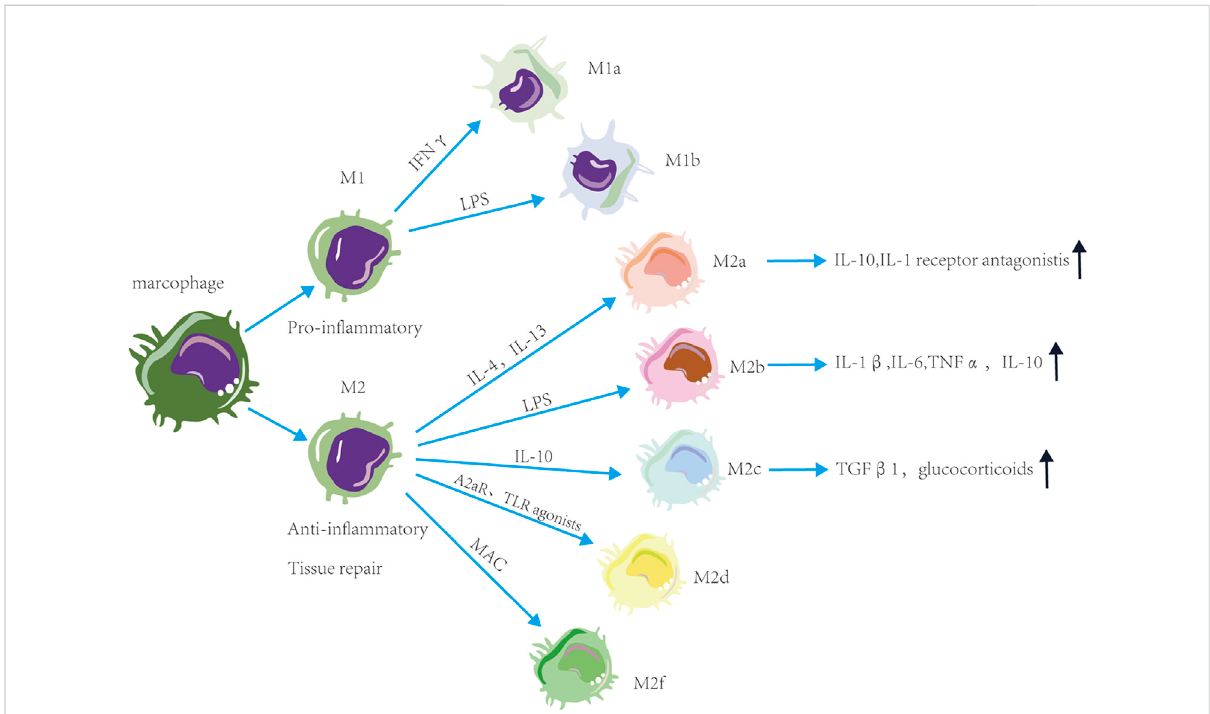
FIGURE 1 Functions and phenotype of macrophages. Macrophages are classi fi ed into M1 and M2 based on the stimulation type and function. M1macrophageshavepro-in fl ammatoryactivity,M2macrophageshaveanti-in fl ammatoryandtissuerepairactivity.Thesemacrophagesaredivided into subtypes based on the stimulation. Proin fl ammatory M1 macrophages are divided into M1a macrophages stimulated by IFN γ and M1b macrophages stimulated by LPS. Anti-in fl ammatory M1 macrophages are divided into M2a macrophages stimulated by IL-4 and IL-13, M2b macrophages stimulated by LPS, M2c macrophages stimulated by IL-10, M2d macrophages stimulated by A 2A R and TLR agonists and M2f macrophages stimulated by macrophage apoptotic clearance. M2a macrophages can suppress the in fl ammatory responses. M2b macrophages have pro- and anti-in fl ammatory activity. M2c macrophages can secrete TGF β 1 and